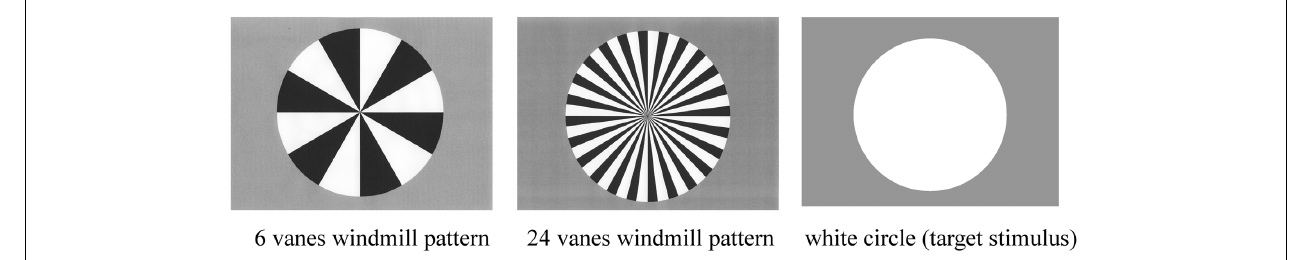
FIGURE 1 | Three stimulus types used in the present study: six-vane circular black-white windmill pattern stimulus, 24-vane stimulus, and an un-patterned, white circle stimulus. The two windmill pattern stimuli were